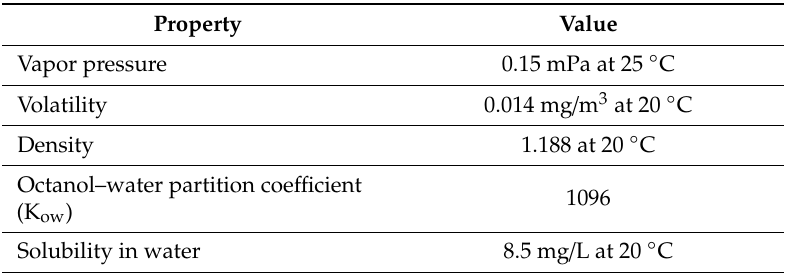
Table 1. Terbuthylazine physicochemical